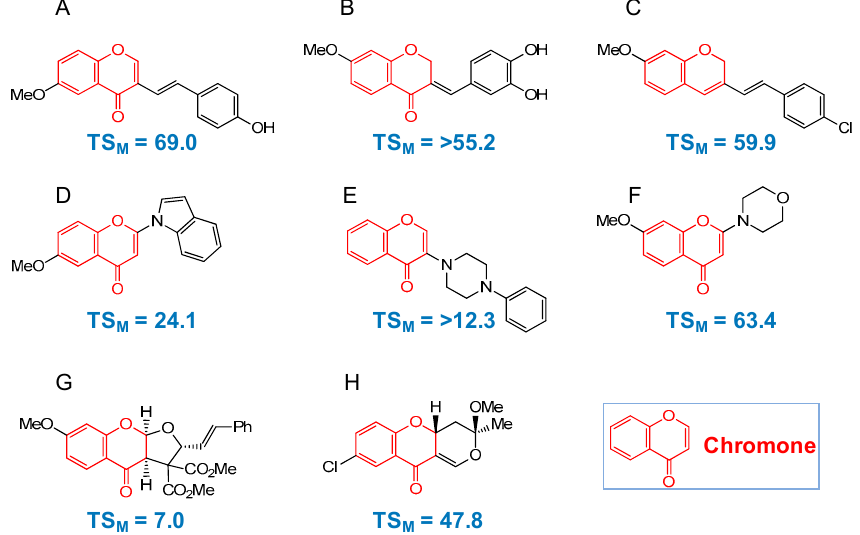
Figure 4. Compounds that showed the highest tumor-specificity (TS M ) values (determined with human OSCC and human oral mesenchymal cell) in eight groups of chromone derivatives. Structure and TS M values of ( A ) that belongs to 3-styrylchromones [30], ( B ) that belongs to 3-benzylidenechromanones [32], ( C ) that belongs to 3-styryl-2 H -chromenes [33], ( D ) that belongs to 2-azolylchromones [34], ( E ) that belongs to 3-( N -cyclicamino)chromones [35], ( F ) that belongs to 2-( N -cyclicamino)chromones [36], ( G ) that belongs to furo[2,3- b ]chromones [37] and ( H ) that belongs to pyrano[4,3- b ]chromones [38] were cited with permission.